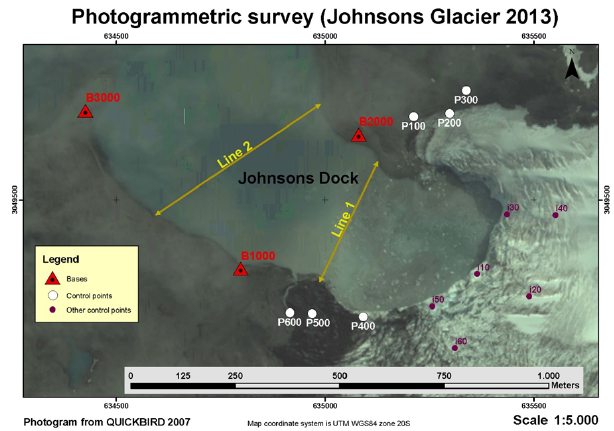
Figure 3. Location of the various kinds of control points. Red tri- angles: location of the bases, measured using GNSS techniques, where theodolite was positioned (B1000, B2000, B3000). White circles: control points measured using GNSS techniques (P100, P200, P300, P400, P500, P600). Magenta points: other control points, measured using direct intersection method (I10, I20, I30, I40, I50, I60 points). Line 1 and Line 2 represent the zodiac boat tracks from which the photographs were taken. The scale of the fig- ure does not match with the numerical map scale indicated. The latter corresponds to the full-size printed version of the figure. This comment also applies to Figs.